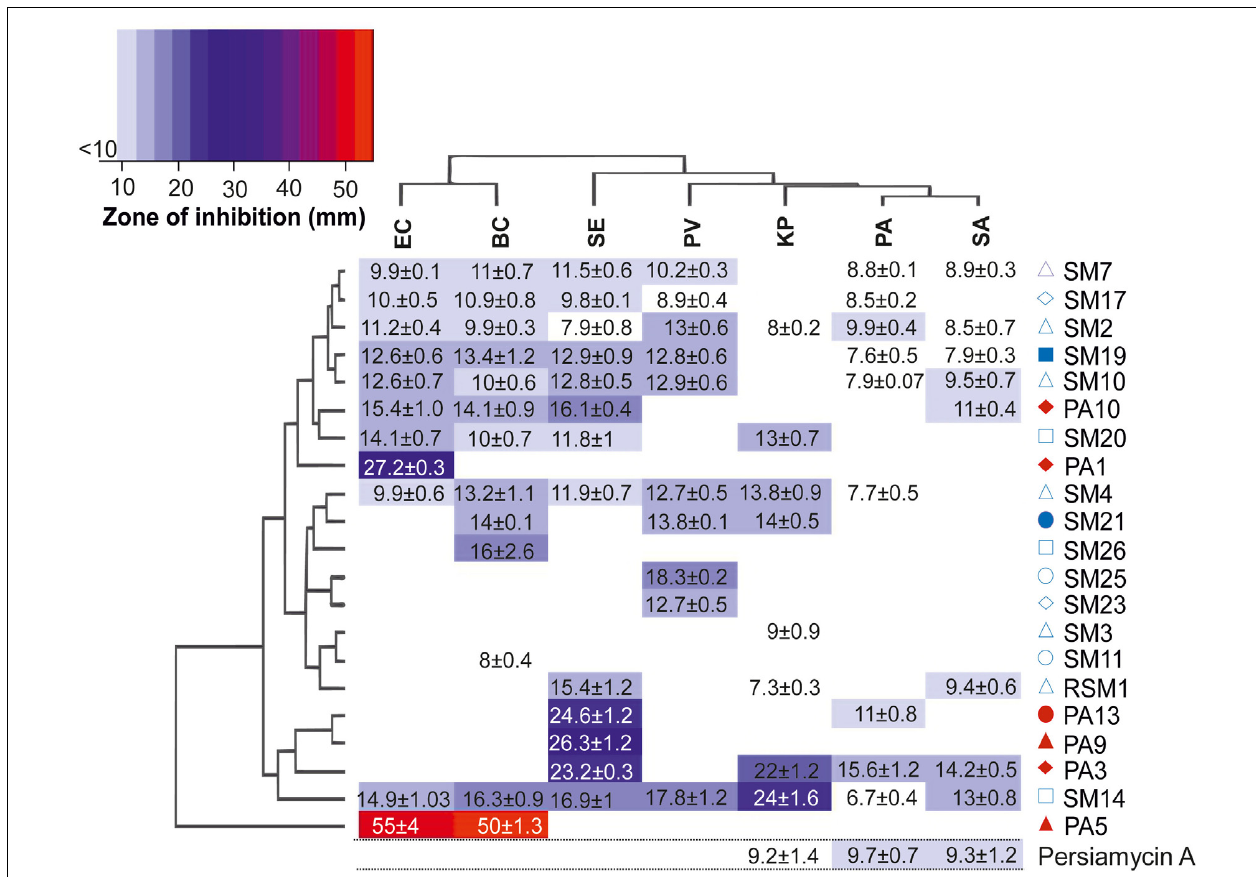
FIGURE 2 | Antibiotic activity of culture extracts. Heatmap diagram illustrating the antimicrobial properties of 22 culture samples probed against seven pathogenic bacterial strains. Colors on the scheme correspond to the diameter of the zone of growth inhibition (mm) in disk diffusion assays. The clustered heat-map reveals two-way display of antibacterial data matrix between the different isolates and the pathogens tested. The hierarchical cluster analyses of the rows and columns determine the relationships of the isolates and the pathogens based on the observed results, respectively. Legend: PV, P. vulgaris ; BC, B. cereus ; KP, K. pneumoniae ; EC, E. coli ; SE, S. enterica ; PA, P. aeruginosa , and SA, S. aureus . The red and blue symbols adjacent to the isolated bacterial strains correspond to sponge host ( Figure 1 ) from which the strain was isolated. Activity of persiamycin A was tested with pure isolated